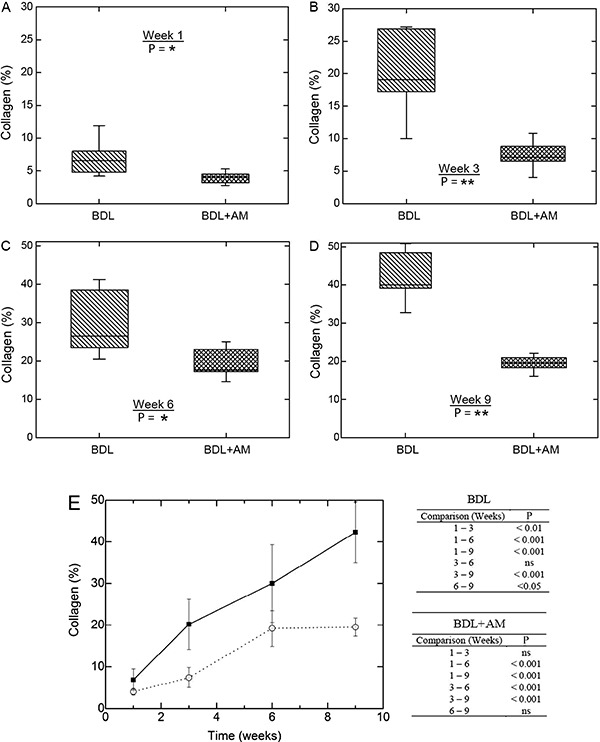
Quantitative evaluation of collagen deposition. Median with interquatile range of collagen deposition in the experimental groups BDL and BDL+AM at week 1 (A), week 3 (B), week 6 (C), and week 9 (D) after fibrosis induction. *P<0.05; **P<0.01, unpaired Student's t-test. E, Means±SD of collagen deposition progression in BDL (squares) or BDL+AM (circles) groups at different time points. The tables represent the significance between time points in BDL and BDL+AM groups, respectively (one way ANOVA followed by Tukey's multiple comparisons test, ns: not significant). BDL: bile duct ligation; AM: amniotic membrane.